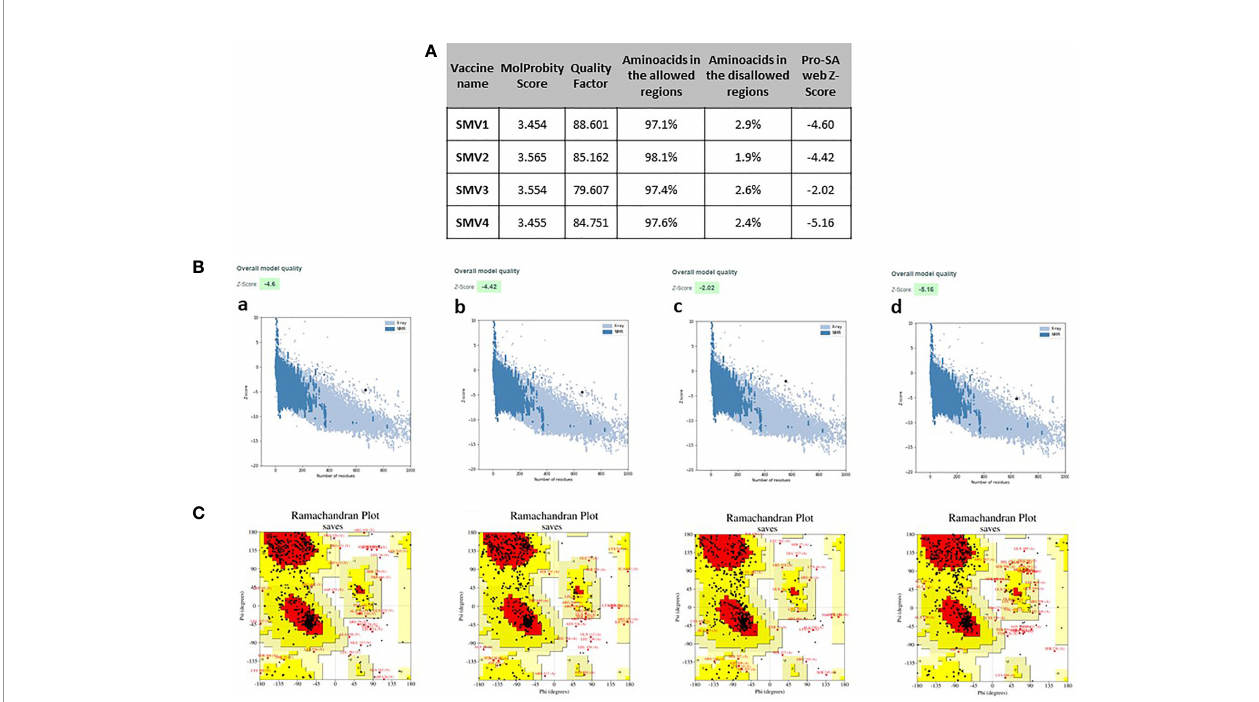
FIGURE 4 | Re fi nement and validations characteristics of S. marcescens vaccine constructs (A) ProSA Z-score (highlighted as a black dot) (B) is displayed in a plot that contains the Z-scores of all experimentally determined protein chains currently available in the Protein Data Bank; Ramachandran plotanalysis (C) , indicating residues in the favored regions (red), allowed regions (yellow), generously allowed regions (light yellow) and disallowed regions (white). a: SMV1, b: SMV2, c: SMV3, d: SMV4.